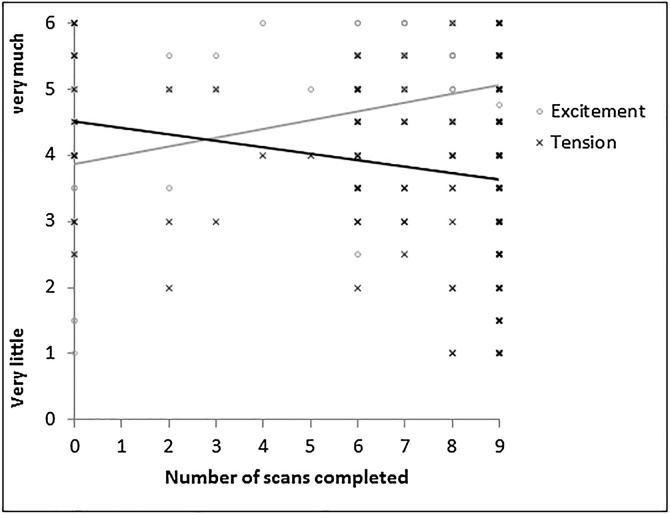
Number of scans completed plotted against excitement and tension towards the scan. Data visualized is from emotional state before MRI scan, emotional states before MRI simulation and after MRI scan showed similar patterns.